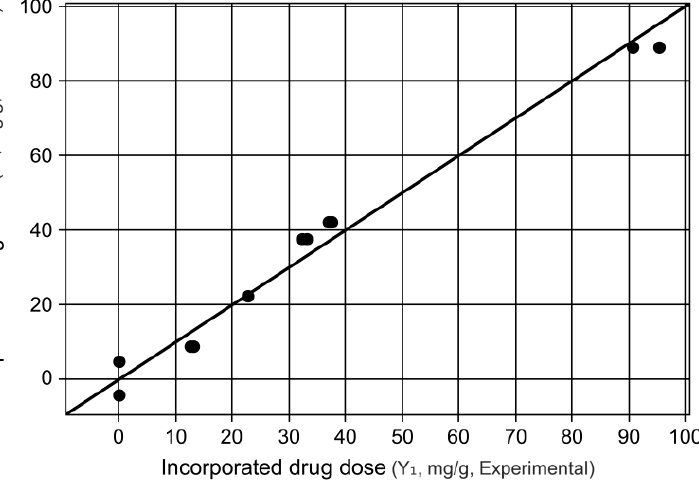
Figure 2. Graph of experimental values vs. predicted values of incorporated drug dose in mg/g.